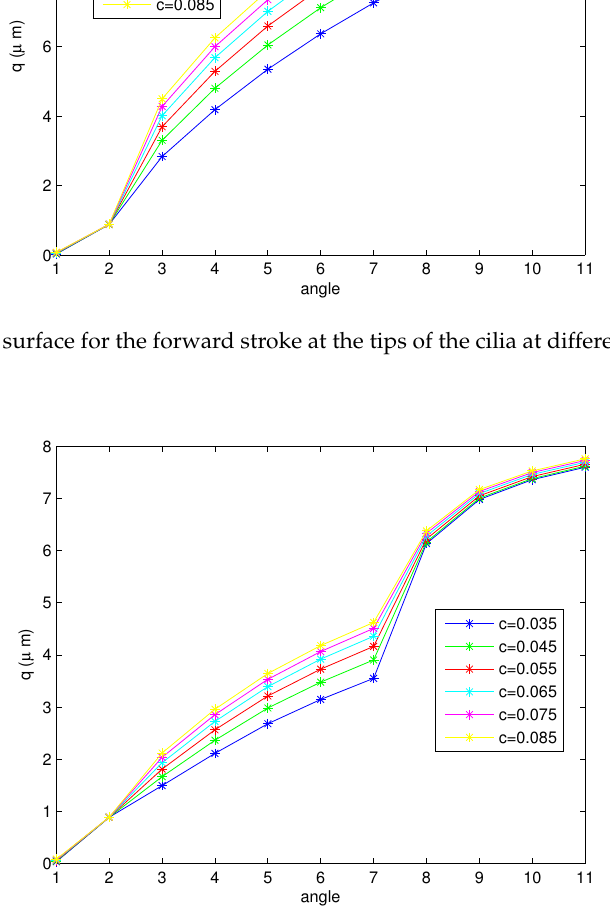
Figure 12. The free surface for the forward stroke at the tips of the cilia at different values of c when r = e − θ